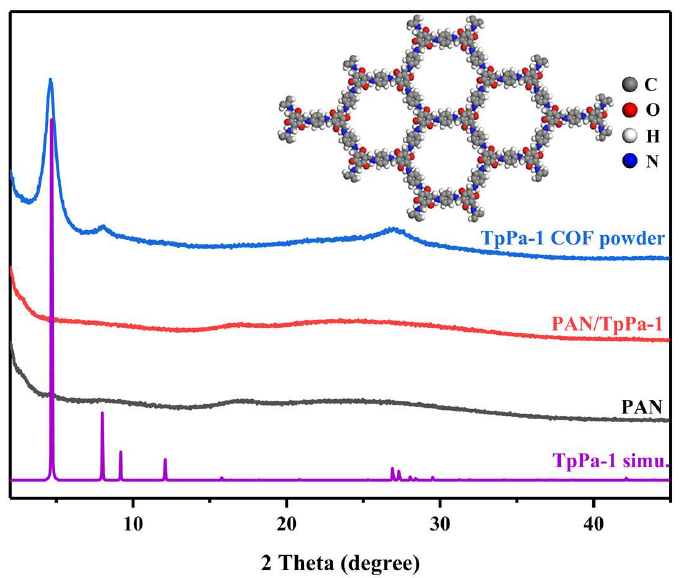
Figure 4. XRD patterns of TpPa–1, PAN/TpPa–1 nanofiber, pure PAN nanofiber, and simulation of